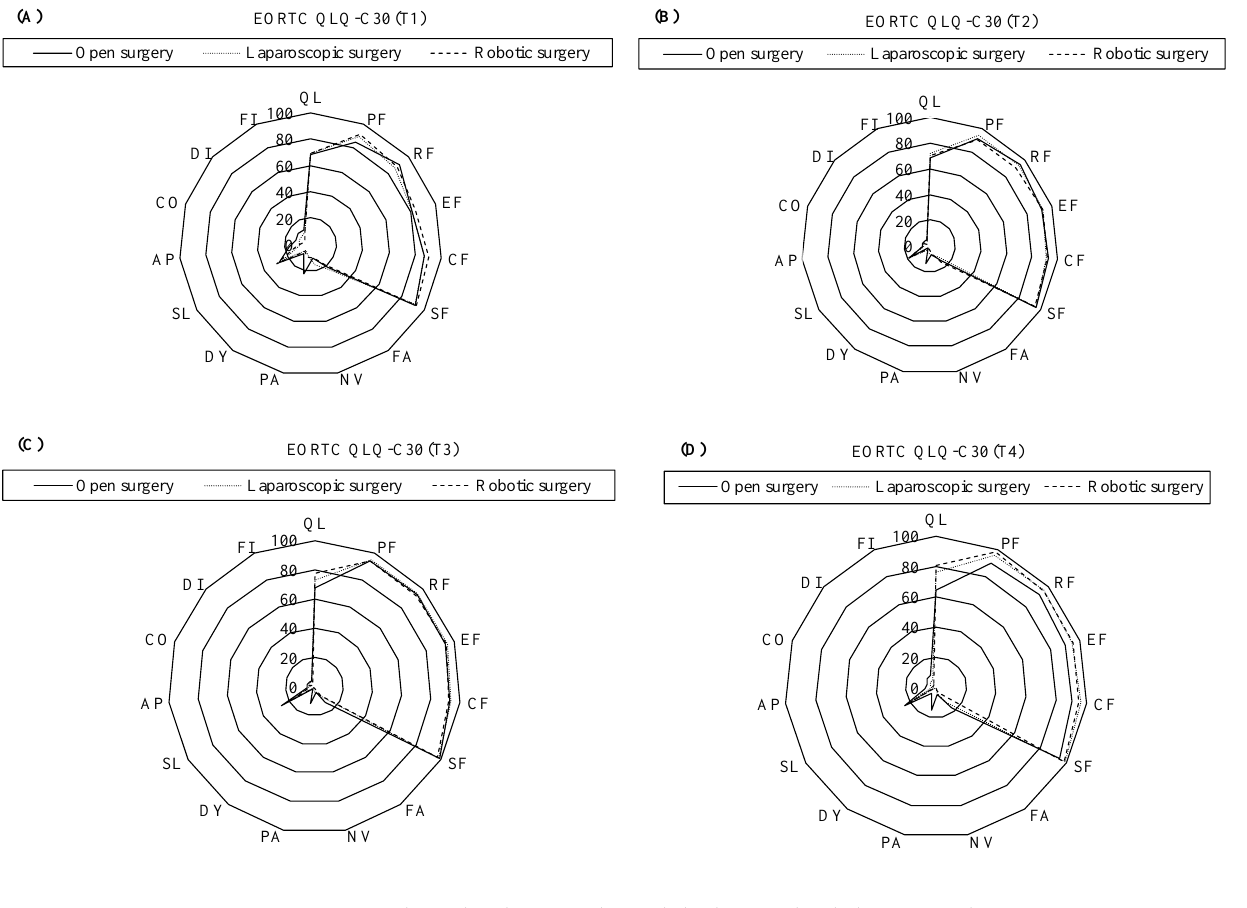
Figure 3. The radar diagram showed the longitudinal changes in the European Organisation for Research and Treatment of Cancer Quality of Life Questionnaire Core 30 (EORTC-QLQ-C30) in hepatocellular carcinoma patients compared among three surgery types at different time